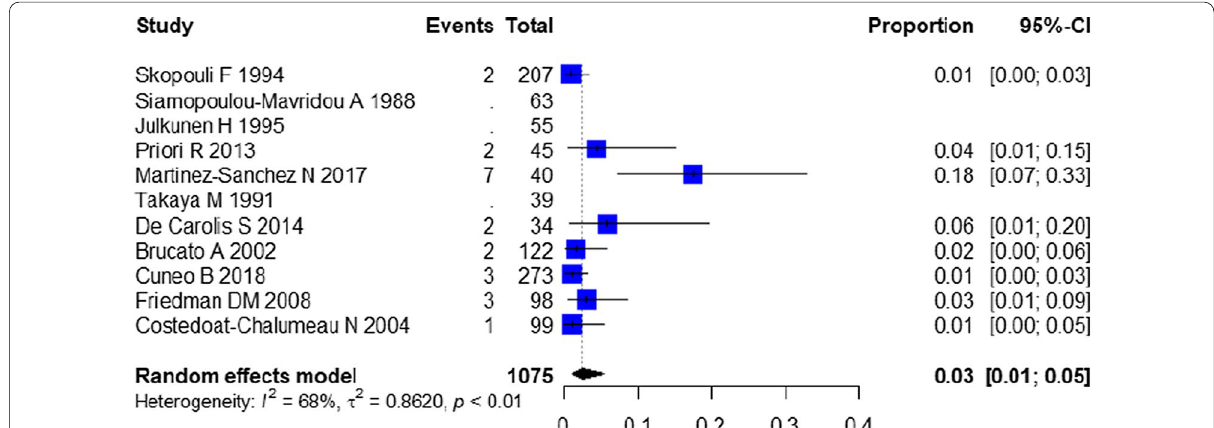
Fig. 9 Meta‑analysis of the incidence of congenital autoimmune heart block in fetuses of women with Sjogren’s syndrome or rheumatic diseases with reactive anti‑SSA/Ro